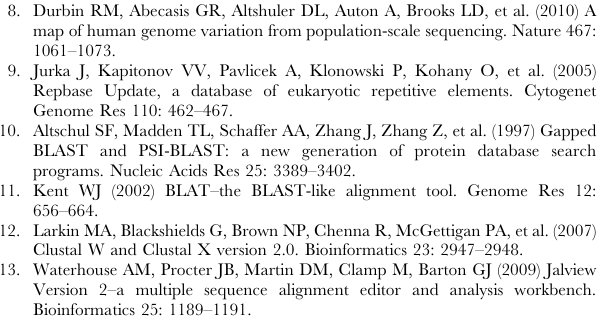
Table S1 A) NCBI trace archive sequences used for AluY Clustal alignment (Figure 1A). B) Complete list of NCBI non-primate trace archive databases identified as contaminated. C) Sequences in non- primate NCBI genome assemblies identified as human. D) Sequences in non-primate UCSC genome assemblies identified as